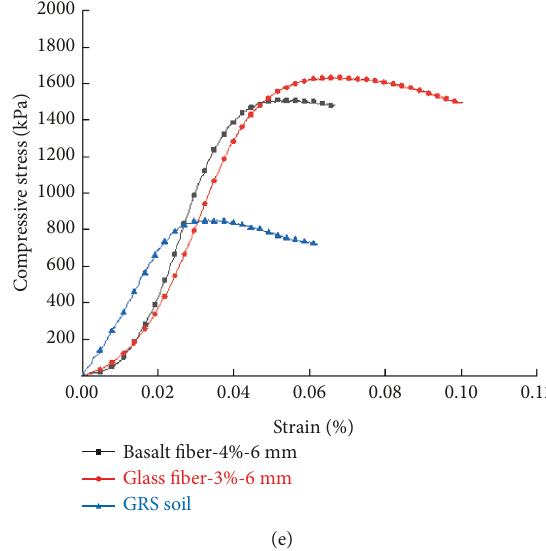
Figure 5: Compressive strength